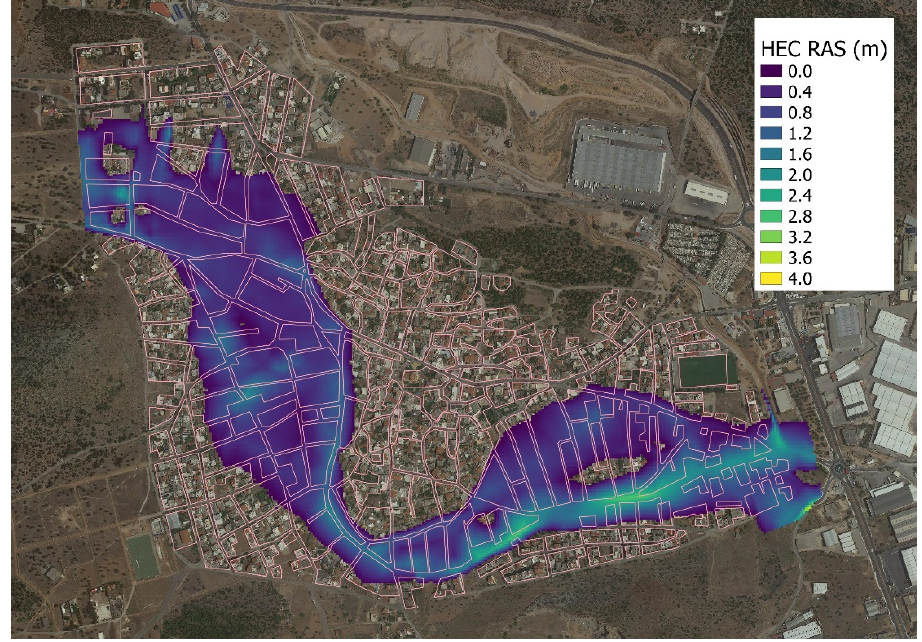
Figure 13. Results of the calibrated HEC-RAS for maximum water depths.